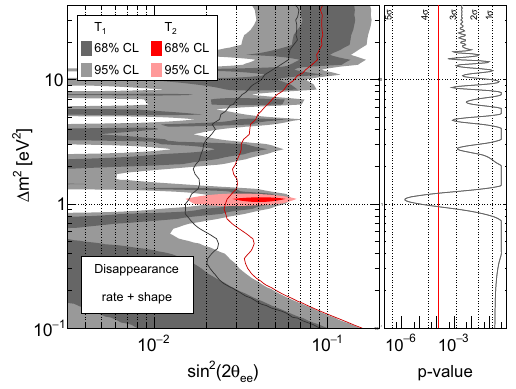
Fig. 4 Confidence regions at 68% and 95% CL for pseudo-data gen- erated by the toy disappearance experiment assuming the existence of a sterile neutrino with sin 2 ( 2 θ) = 0 . 04 and Δ m 2 = 1eV 2 . The 95% CL discovery sensitivity is shown for both the statistic T 2 (red line) and T 1 (grey line). The right panel shows the minimal size of a test based on T 1 that is required to reject the no-signal hypothesis as a function of the Δ m 2 value (grey line). The minimal test size for T 2 (red line) is independent by Δ m 2 as all values are tested simultaneously. Differently from T 2 , T 1 would reject the no-signal hypothesis even for a test size of 10 − 5 (corresponding to a 4 σ two-sided Gaussian deviation).